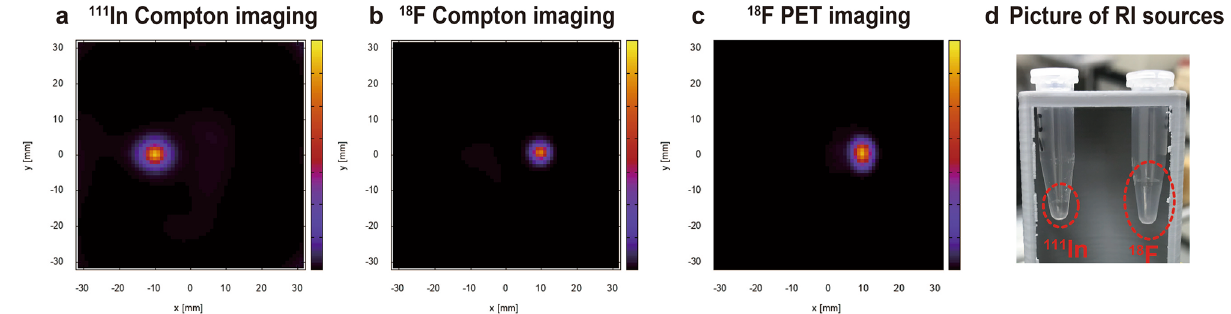
Figure 5. Simultaneous 111 In and 18 F imaging results. ( a ) A reconstructed image of an 111 In radioisotope obtained by Compton imaging, using 245 keV gamma rays for the reconstruction. ( b ) A reconstructed image of an 18 F radioisotope obtained by Compton imaging, using 511 keV gamma rays for the reconstruction. ( c ) A reconstructed image of the 18 F radioisotope obtained by PET imaging. ( d ) A picture of RI sources in micro tubes.